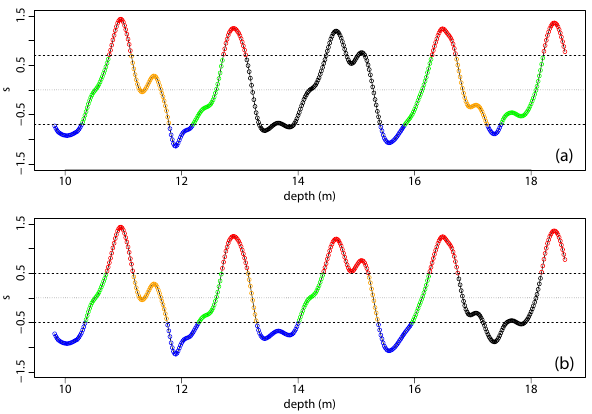
Fig. 3. Part of the standardised H 2 O 2 signal, for depths between 9.8m and 18.6m, showing the “issues” (regions of dating uncer- tainty) caused by fluctuations in the signal and identified using two different values of the threshold ν for classifying individual points. Points within “issues” are black; points within peaks (labelled P in main text) are coloured red; descending points (D) are orange; troughs (T) are blue; and ascending points (A) are green. (a) Thresh- √ old ν = 1 / 2. (b) Threshold ν = 0 .